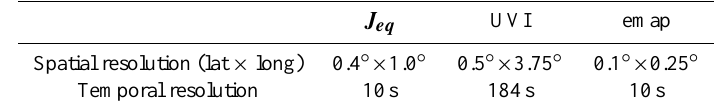
Table 1. The native spatial and temporal resolutions of the various data types.